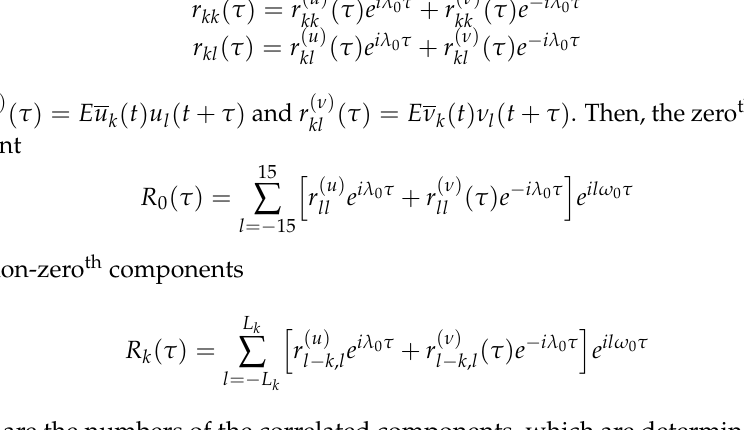
Figure 19. The dependences of the first, second, and third cosine covariance components estimators on starting lag for the second ( a ) and third ( b ) stages.